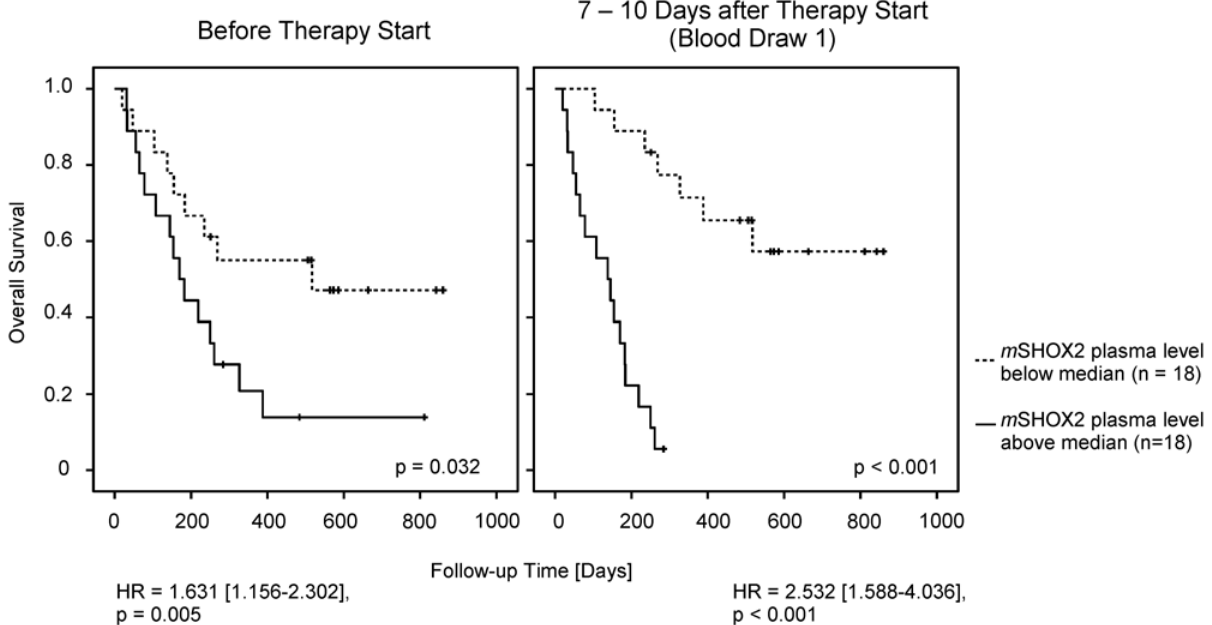
Fig 3. Cox Proportional Hazards and Kaplan-Meier survival analysis of all 36 patients. The median plasma mSHOX2 value at baseline was 2.88% PMR, while the median one week after therapy start was 2.16%